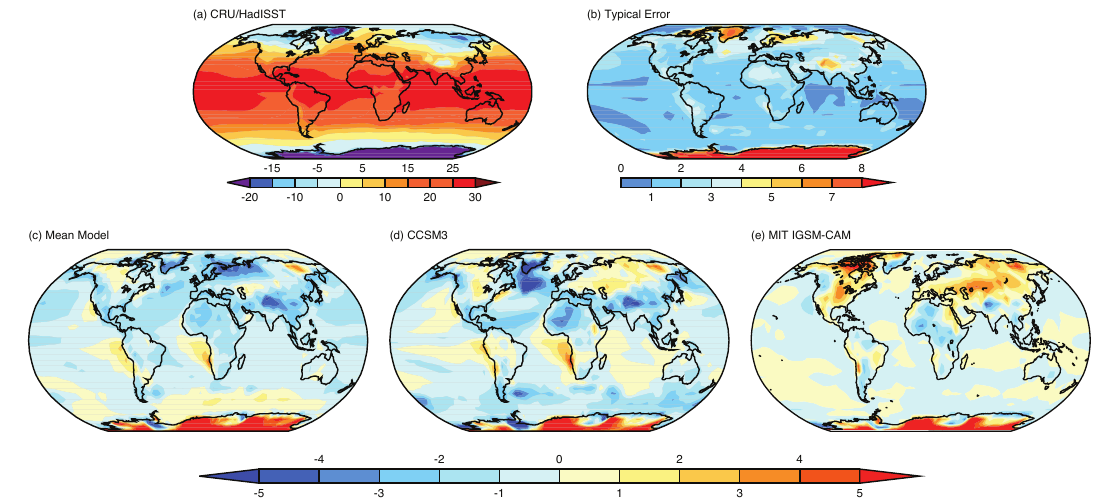
Fig. 7. (a) Observed annual-mean HadISST1 climatology for 1980–1999 and CRU surface air temperature climatology over land for 1961– 1990; (b) root-mean-square model error ( ◦ C), based on all available IPCC model simulations (i.e., square-root of the sum of the squares of individual model errors, divided by the number of models); (c) IPCC AR4 multi-model mean error ( ◦ C), simulated minus observed; (d) CCSM3 model error ( ◦ C), simulated minus observed; and (e) IGSM-CAM model error ( ◦ C), under median climate sensitivity, simulated minus observed. The model results are for the same period as the observations. In the presence of sea ice, the SST is assumed to be at the approximate freezing point of sea water ( − 1.8 ◦ C). Adapted from Randall et al. (2007), Fig. S8.1b.